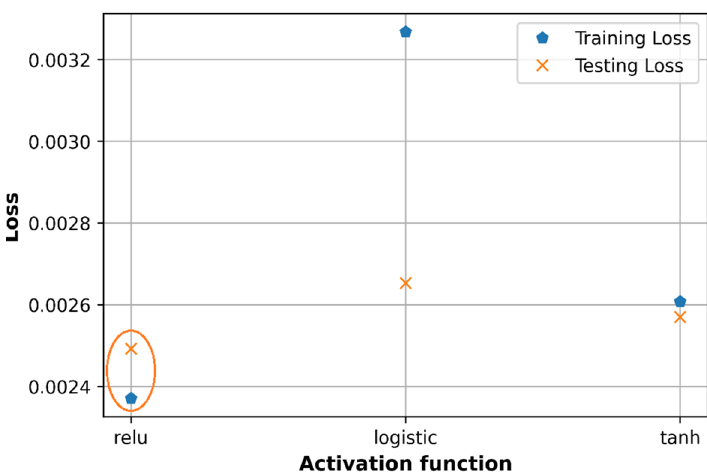
Figure 17. Comparison of loss with different activation functions.